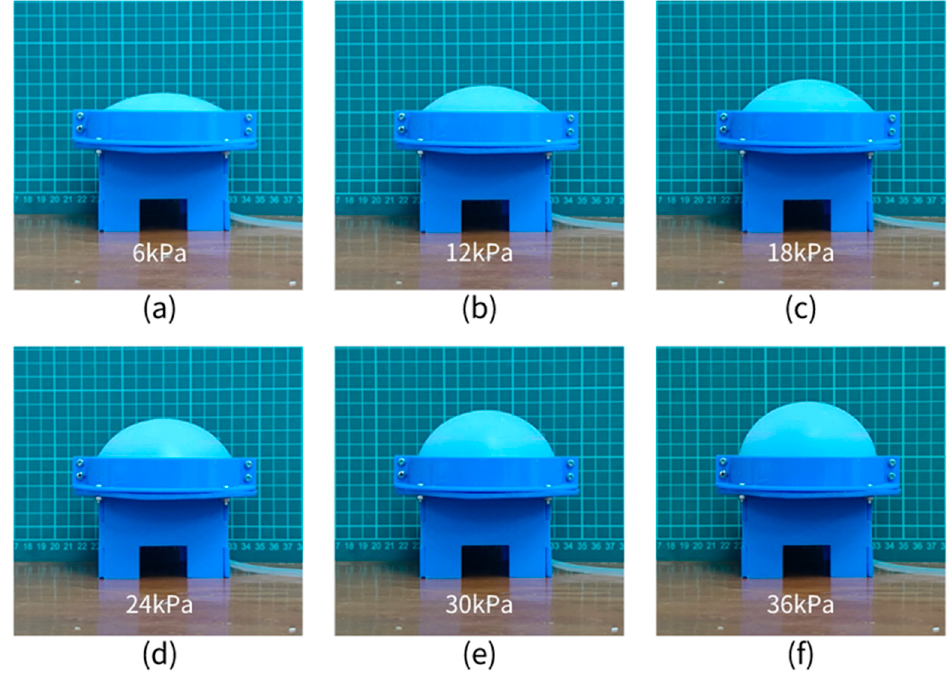
Figure 15. CTPM experimental diagram. ( a – f ) respectively represent the state record diagram of the circular thin plate model with 6 kPA–36 kPa pressure increasing at an interval of 6 kPa.